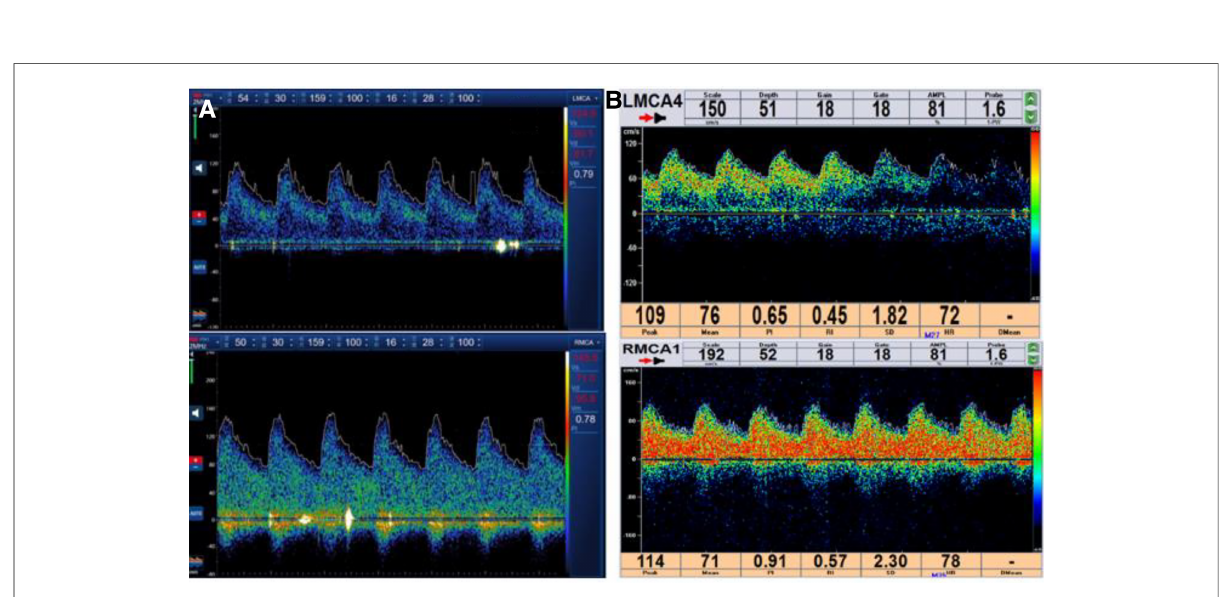
FIGURE 3 ( A ) Spectrum results of the bilateral middle cerebral artery detected by TCD after CAS. ( B ) Spectrum results of the bilateral middle cerebral artery detected by TCD before the operation. TCD, transcranial Doppler ultrasound; CAS, carotid artery stent